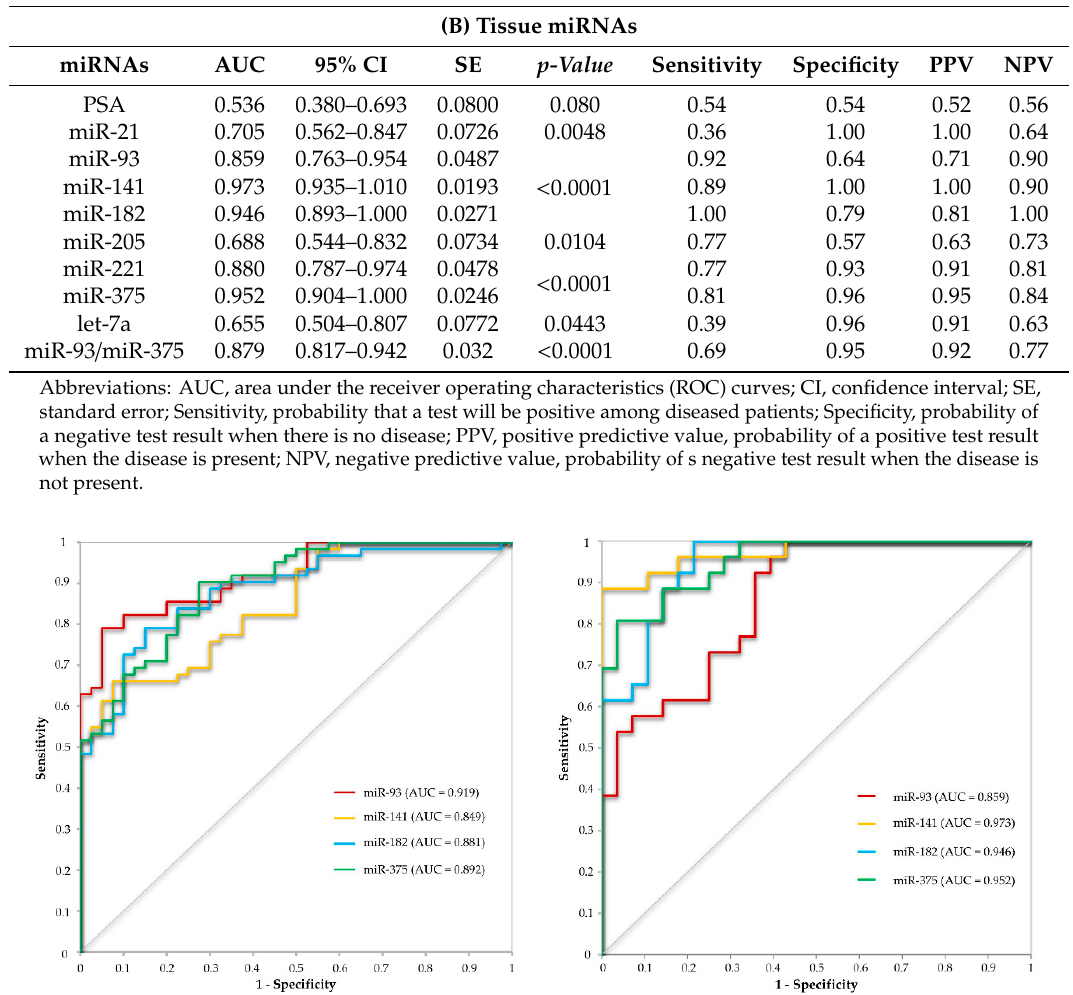
Figure 2. Receiver operating curve (ROC) curve analysis with the use of miRNAs with the